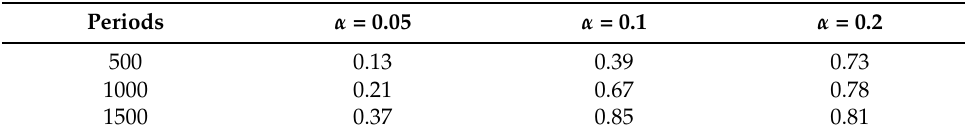
Table 1. Impact of learning rate α on scheduling quality.